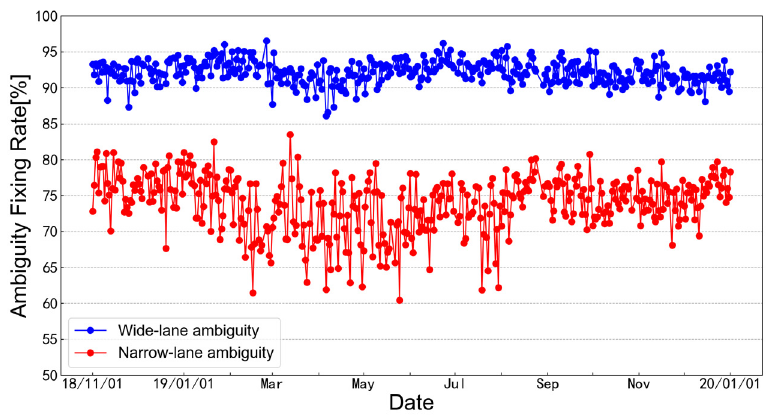
Figure 10. Fraction of passes with resolved wide-lane and narrow-lane ambiguities for the HY-2B satellite from November 2018 to the end of 2019.